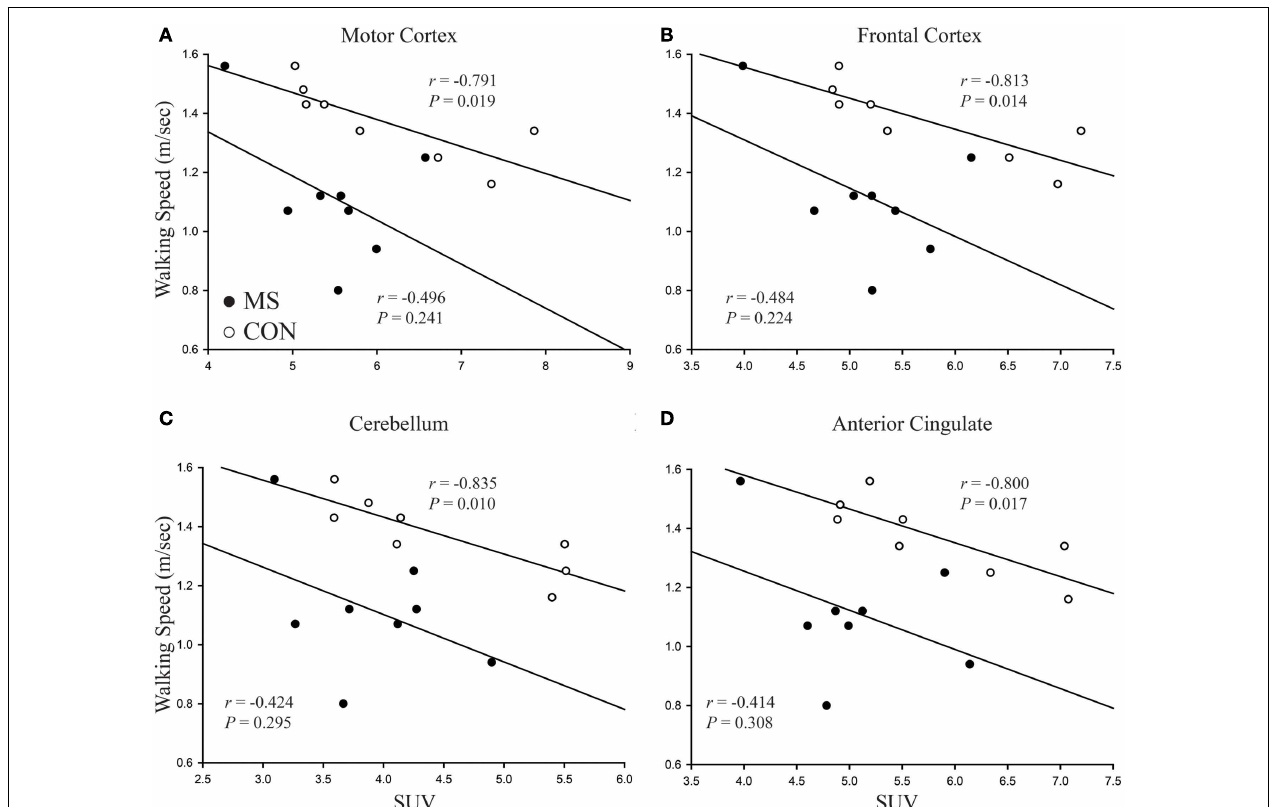
weaker, patients with MS show no statistical significance while correlations for the control group all reach statistical significance. (A) Motor cortex, (B) frontal cortex, (C) cerebellum, (D) anterior cingulate.